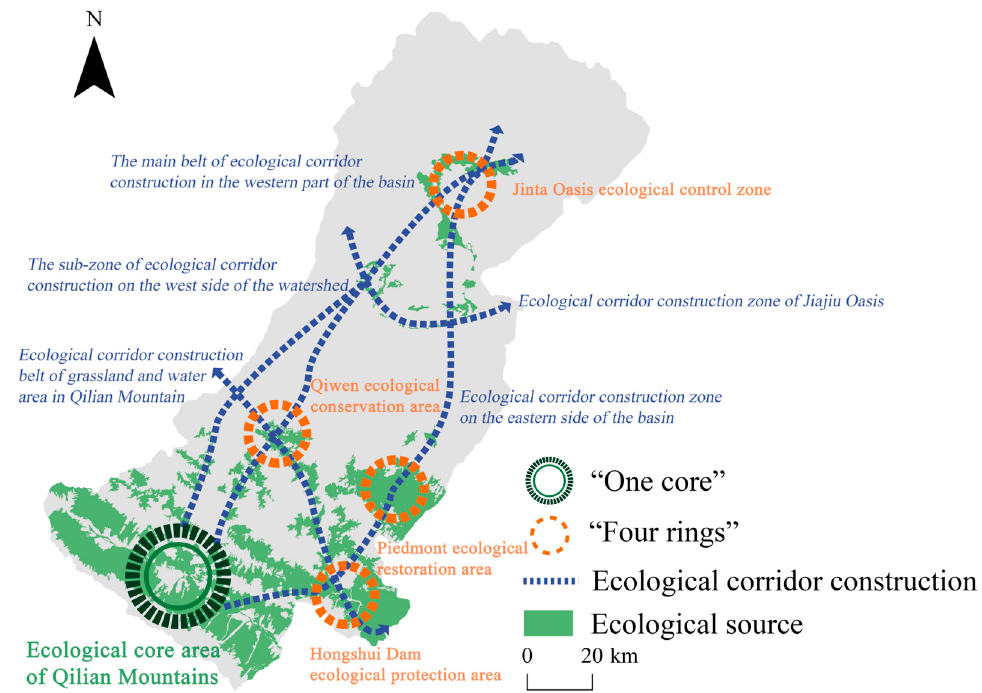
Figure 14. EN structure of Taolai River Basin.